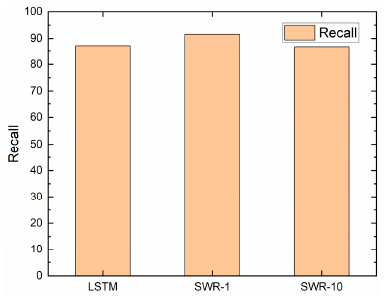
Figure 9. Recall. Figure 9. Recall.